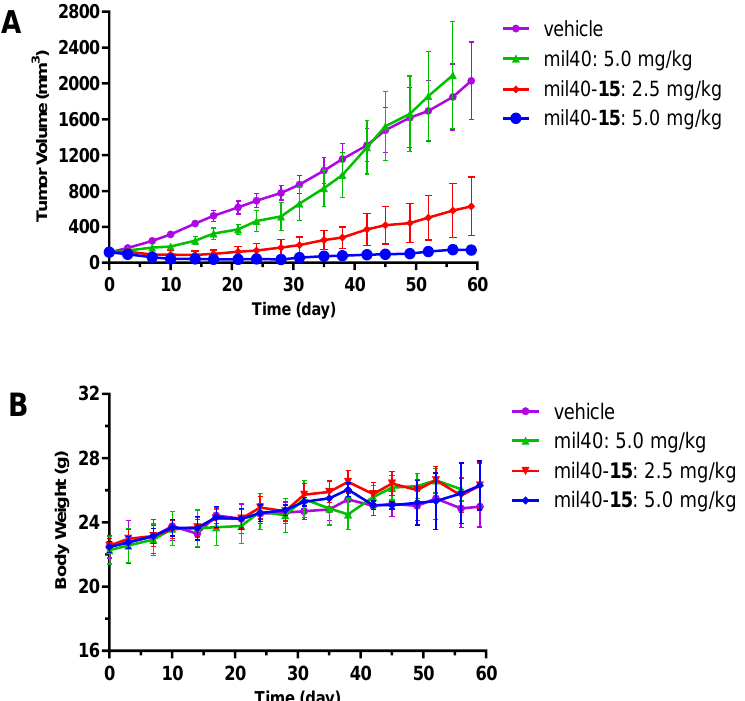
Figure 6. Xenograft studies of the Cys-linker-MMAE-based ADC. ( A ) The tumor volume of the test animals during the treatment and observation period. ( B ) Changes in the body weights of the mice during the observation period. Nude mice were implanted subcutaneously with NCI-N87 cells. When the tumors reached ~120 mm 3 , the animals were given vehicle, mil40, or ADC on days 0, 7, 14, and 21. The results are shown as the mean ± SD, n = 6/group.